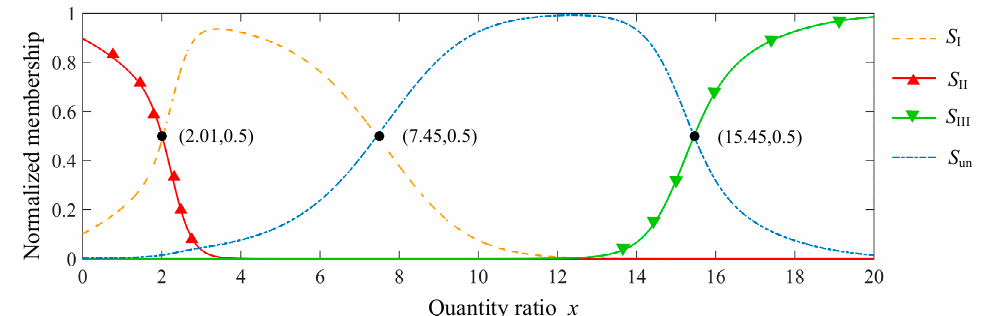
Figure 5. Normalized membership functions with the determined parameters. 311